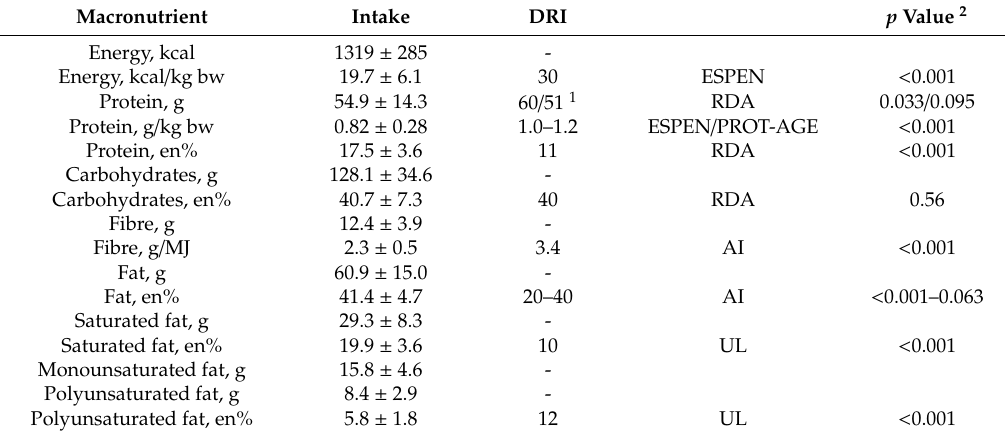
Table 2. Daily mean macronutrient intake of 39 older hip fracture patients compared to the Dietary Reference Intakes from European Society for Clinical Nutrition and Metabolism (ESPEN) [43], the PROT-AGE Study Group [27] and the Health Council of the Netherlands (RDA, AI, UL) [39,40]. Macronutrient